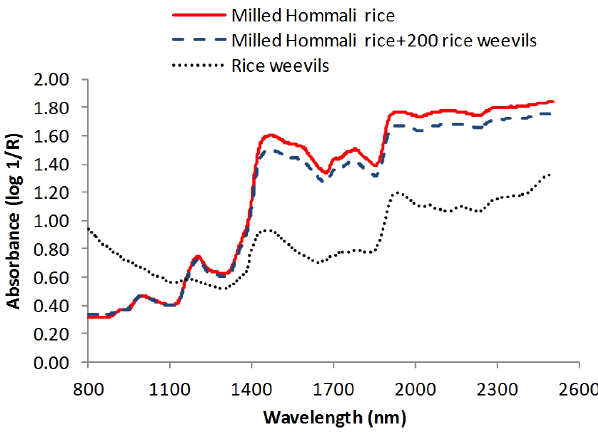
Fig. 3. Raw absorbent spectra of 100% milled Hommali rice, 200 rice weevils infested and 100% rice weevil.